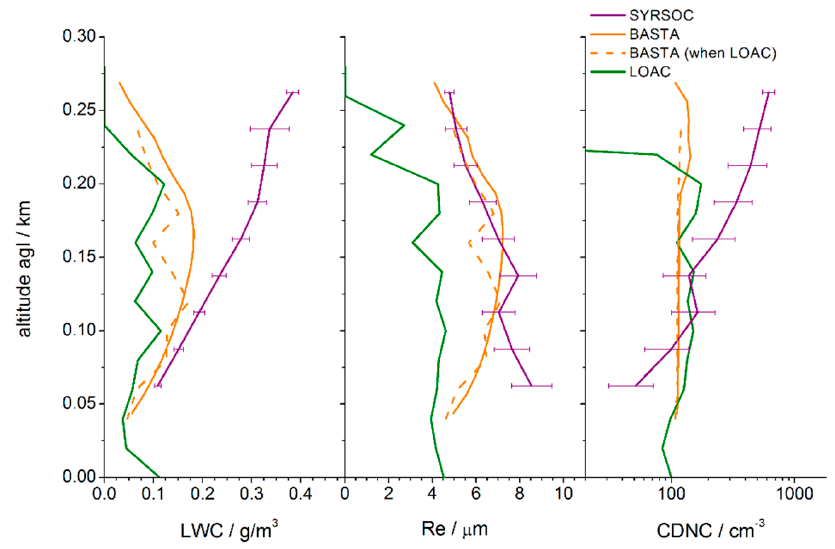
Figure 12. Vertical profile of LWC ( left ), Re ( middle ), CDNC ( right ) derived from LOAC, BASTA, and SYRSOC algorithm between 09:00 and 10:00 on 6 January 2015. Error bars on SYRSOC profiles indicate standard deviation of the mean over the 1-h period.